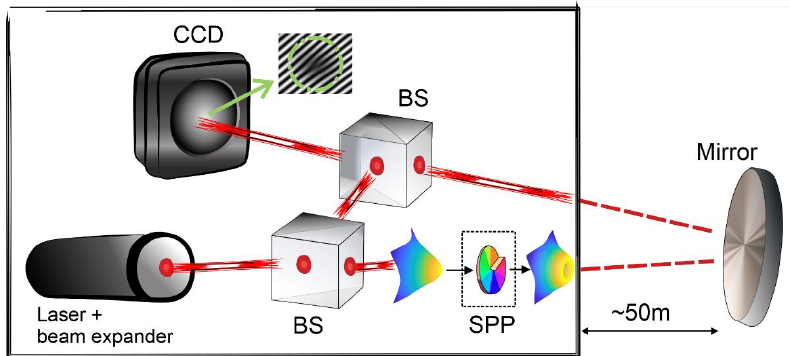
Figure 7. Diagram of an experimental setup for detecting an interferogram with fringes like a fork, BS—beam splitters, SPP—spiral phase plate.